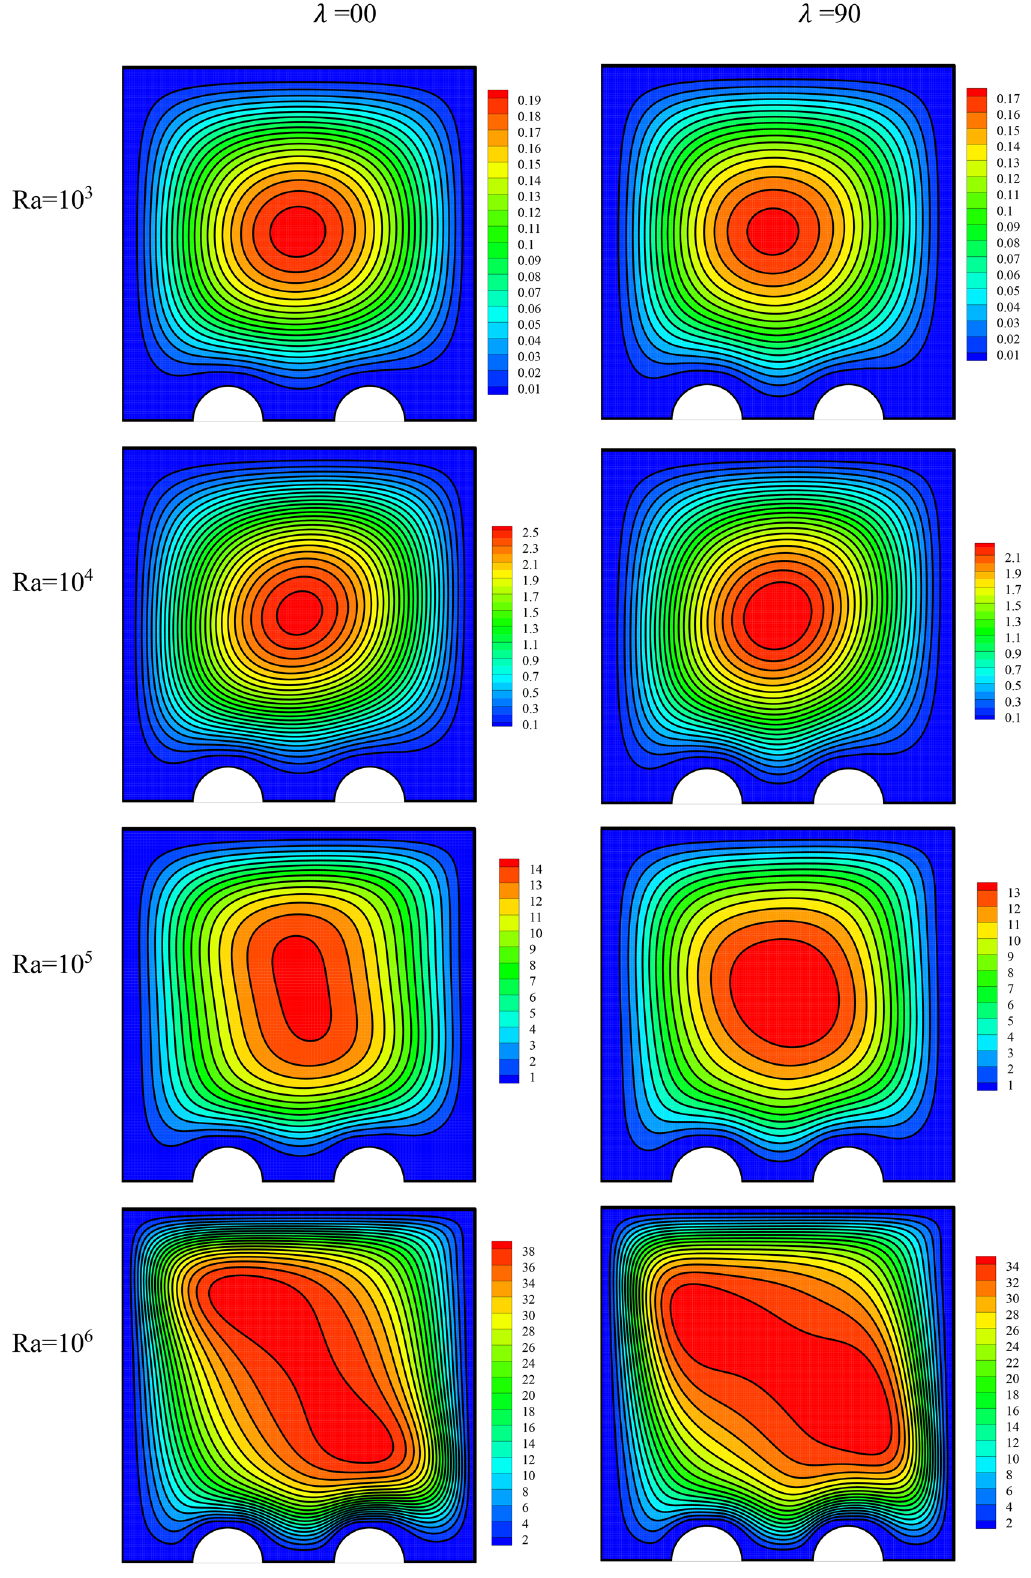
Figure 8. The flow field for varying values of Ra and MF angle at φ = 0.3, γ = 45°, Ha = 20, Rad =